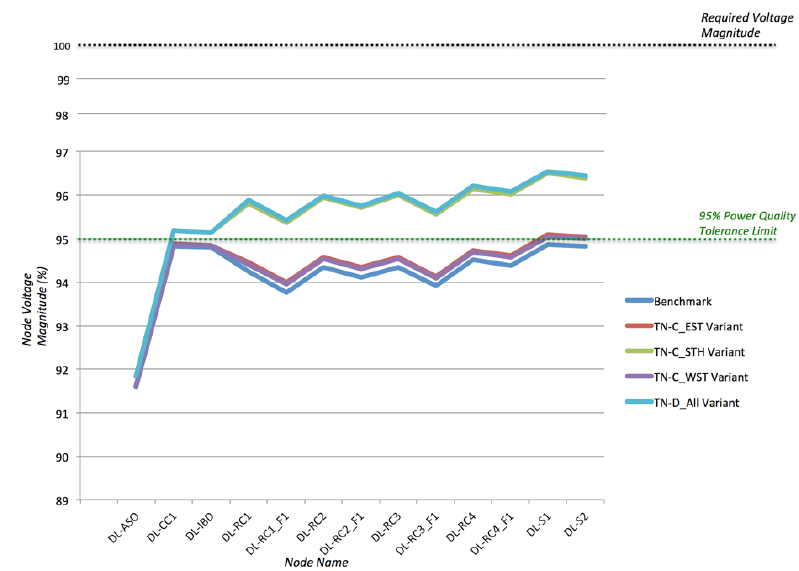
Figure 7. Graphical representation of relative improvement in voltage magnitude arising from variants employing Transmission ESS Integration Topology.